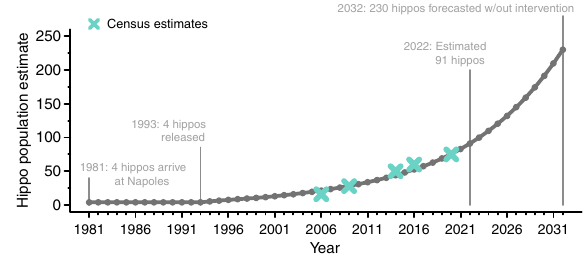
Figure 3. Colombian hippopotamus introduction timeline and population growth